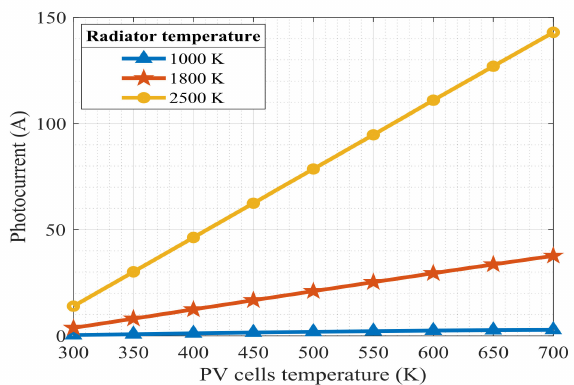
Figure 7. Relationship between PV cells temperature and photocurrent of the TPV system when the temperature of the radiator is at 1000, 1800, and 2500 K.